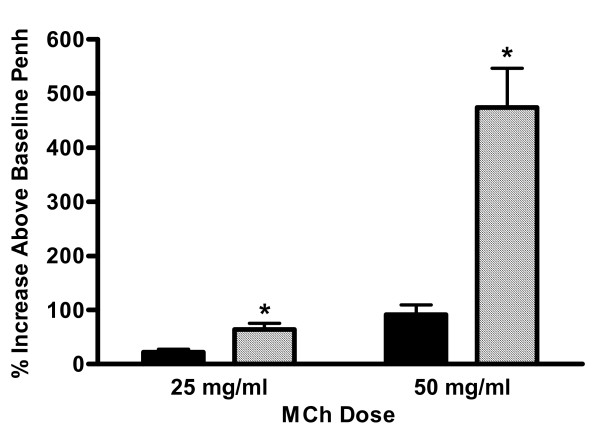
Airway hyperresponsiveness. AHR was assessed 24-hours after the last pulmonary challenge in C5-sufficient (solid bars) and C5-deficient (diagonal bars) mice. Values are reported as the percent increase in Penh of each dose of methylcholine relative to PBS aerosolization. Each value is the mean ± SEM for three experiments; n = 14 mice per group in three experiments for immunized and challenged mice. * indicates p < 0.05 for C5-sufficient compared to C5-deficient at each MCh dose, p = 0.0026 at the 25 mg/ml MCh dose and p < 0.0001 at the 50 mg/ml MCh dose.